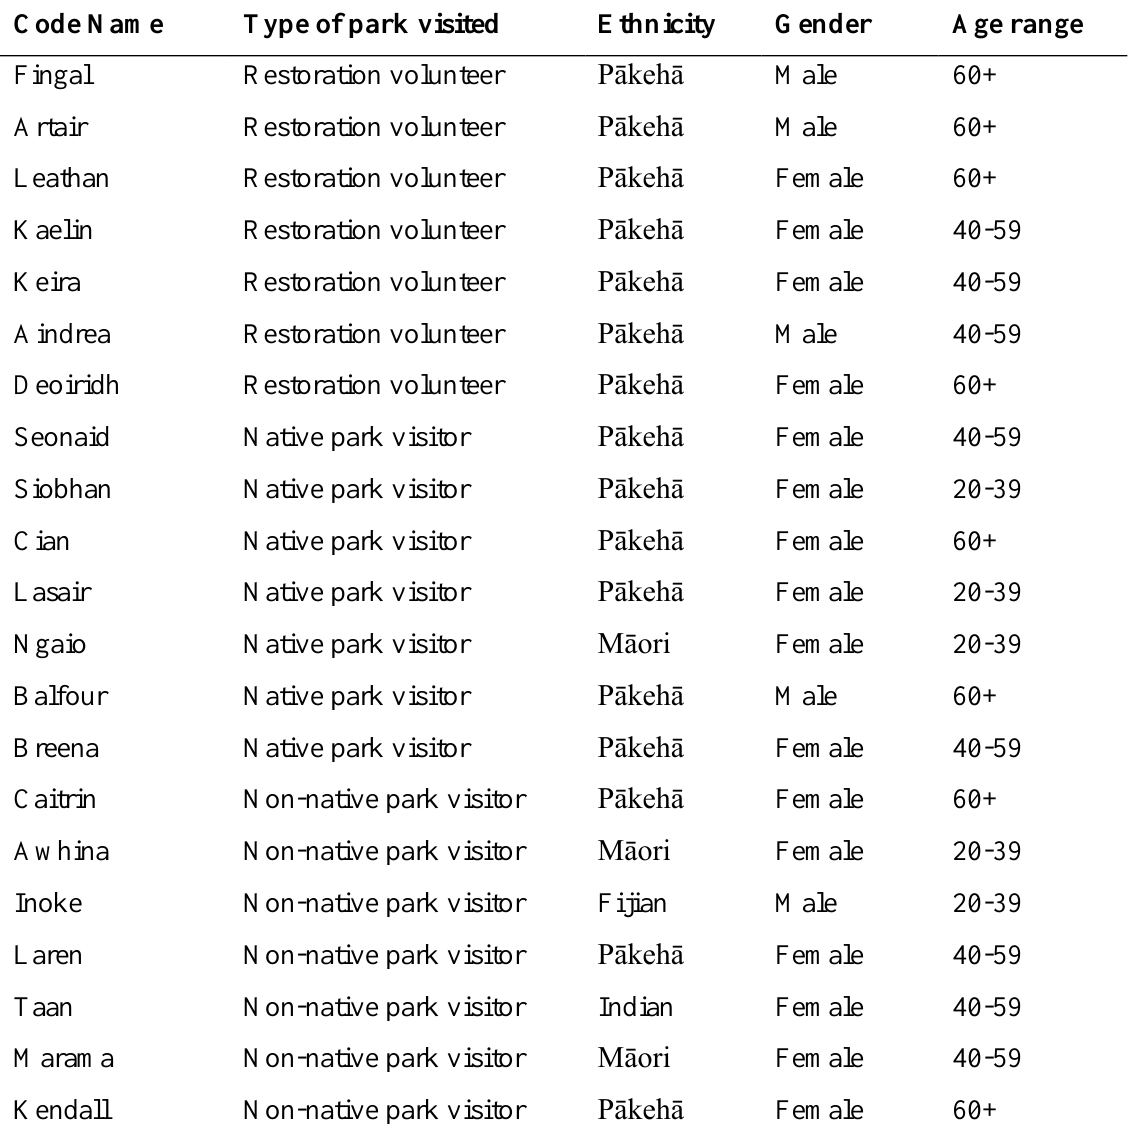
Table A1.1 Code names, type of park visited, ethnicity, gender and age range of each